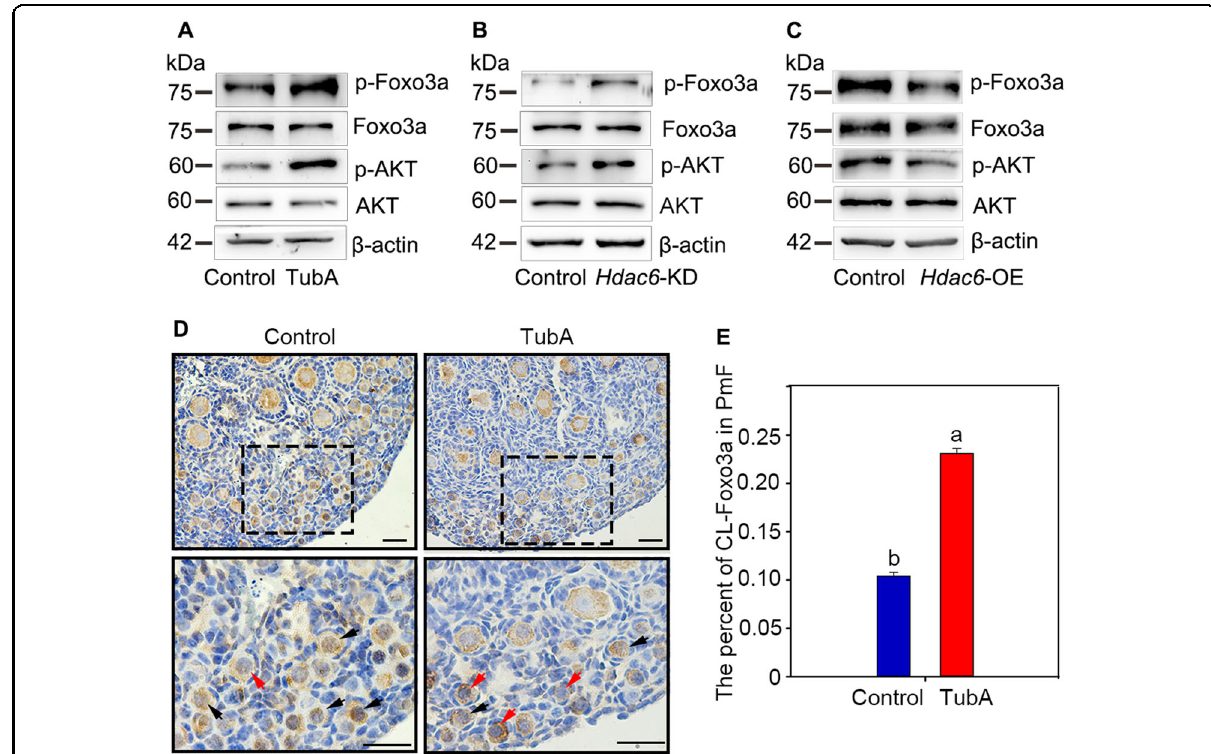
Fig. 4 HDAC6 participates in the maintenance and activation of PI3K signaling. A – C Western blotting results showed that both p-Foxo3a and p-AKT were increased in either TubA or Hdac6 -KD group compared with those in the controls, respectively. On contrary, the levels of both p-Foxo3a and p-AKT were down-regulated by Hdac6 -OE treatment compared with the control. D The immunostaining stain showed that the cytoplasmic translocation of Foxo3 was increased in primordial follicles after treated with Tub A. Red arrow indicates cytoplasm Foxo3a. Black arrow indicates nucleus Foxo3a. E The statistical results showed that the cytoplasmic translocation of Foxo3 was increased in primordial follicles after treated with